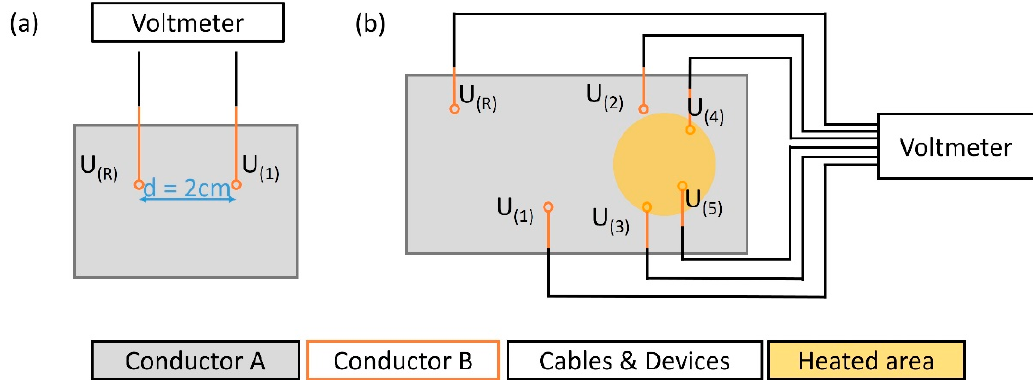
Figure 3. Measurement arrangement used for characterization of the ( a ) flexible thermal element and ( b ) the multi-point temperature sensor array using five measuring terminals and one reference terminal connected to the voltmeter.